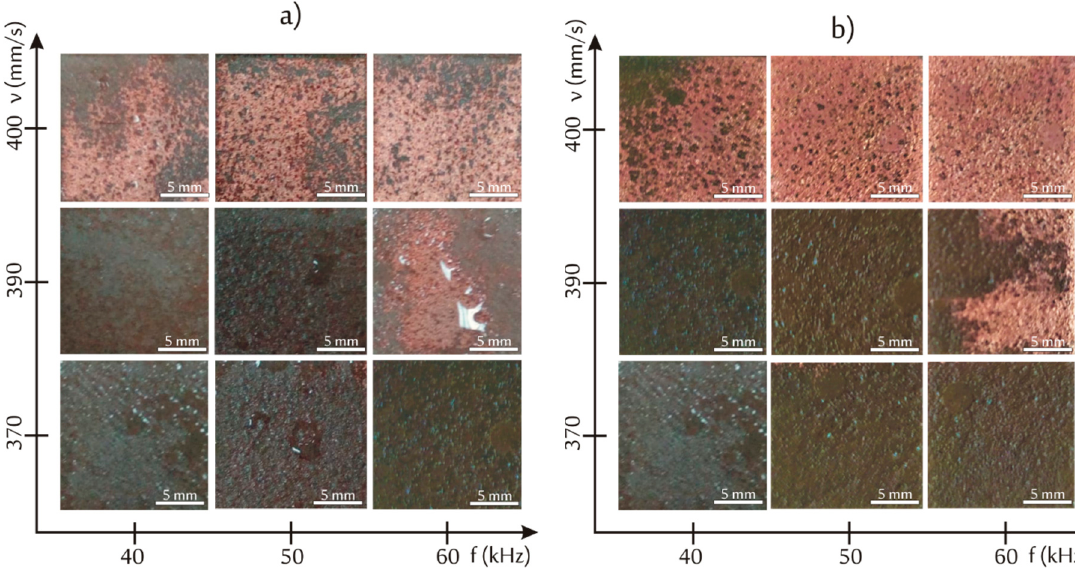
Figure 7. Optical images of the metalized composites: ( a ) D and ( b ) E irradiated at varied frequency and scanning speed of laser beam while maintaining constant power (P = 8 W).